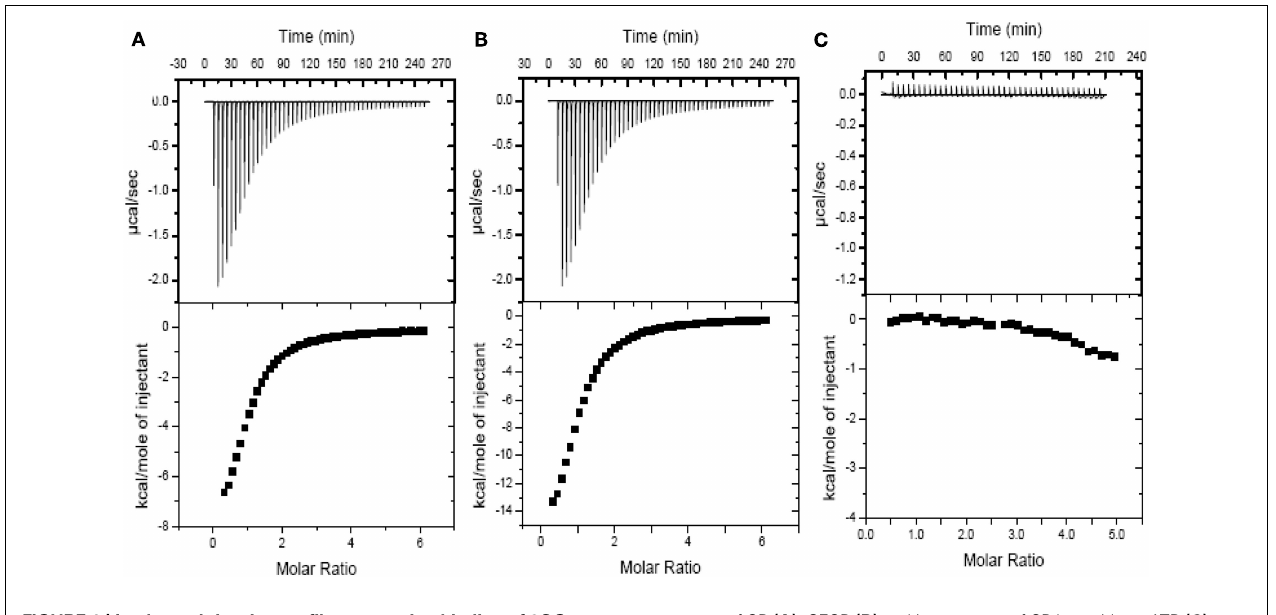
FIGURE 6 | Isothermal titration profiles comparing binding of 2OG to H6PII-tp in the absence and presence of phosphonate analogs or ATP. The upper panel shows the raw data in the form of the heat effect during titration of 120 μ m PII with 2OG (5.0–500 μ m) and ATP in the